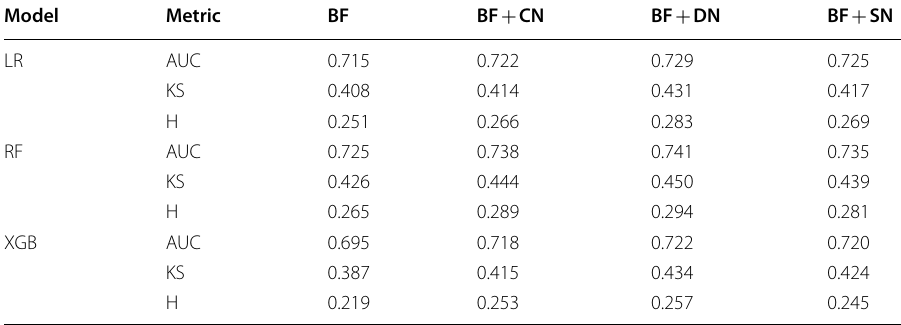
Each metric is measured by the mean of 100 estimates obtained by repeating the outer ten-fold cross-validation procedure ten times. In Appendix 6, Tables 29 and 31 show the 95% and 90% confidence intervals of each mean, and Table 33 shows the mean of 50 estimates obtained by repeating the ten-fold cross-validation procedure five times